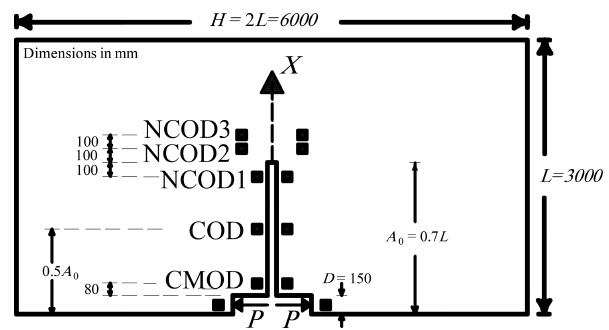
Figure 1. Specimen geometry. Edge-cracked rectangular plate of length L , width H , and crack length A 0